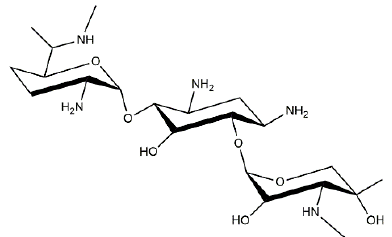
Figure 8. Schematic representation of gentamycin’s chemical structure.